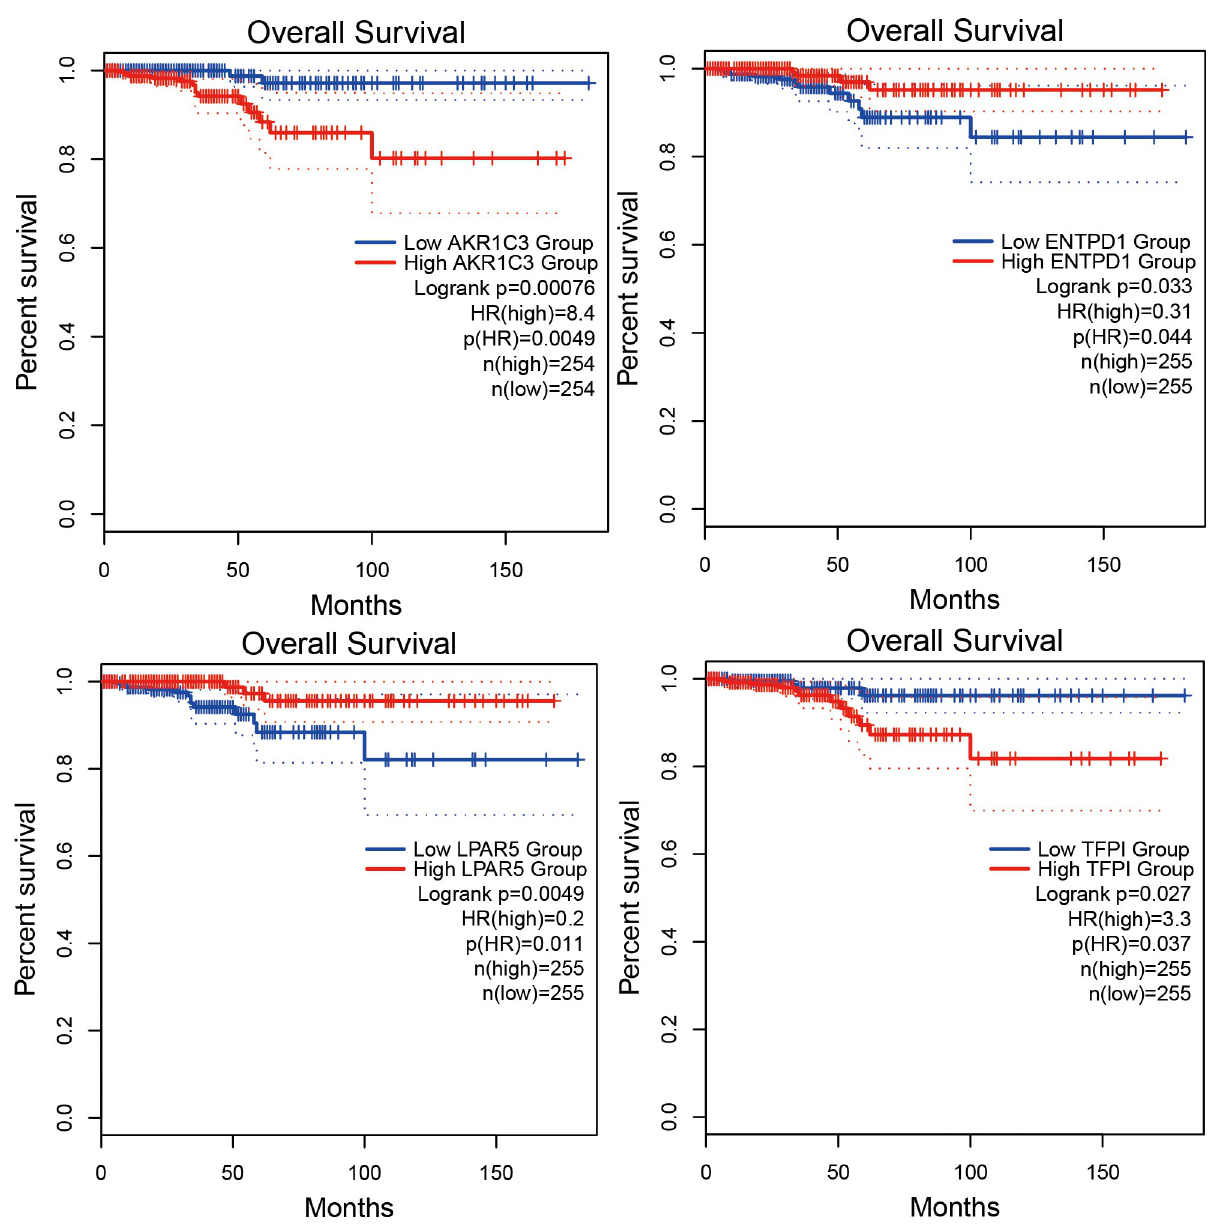
Fig 5. The association between the expression of the four hub genes and the overall survival of patients with PTC via GEPIA analysis. Red curve denotes high expression level, while blue curve denotes low expression level.